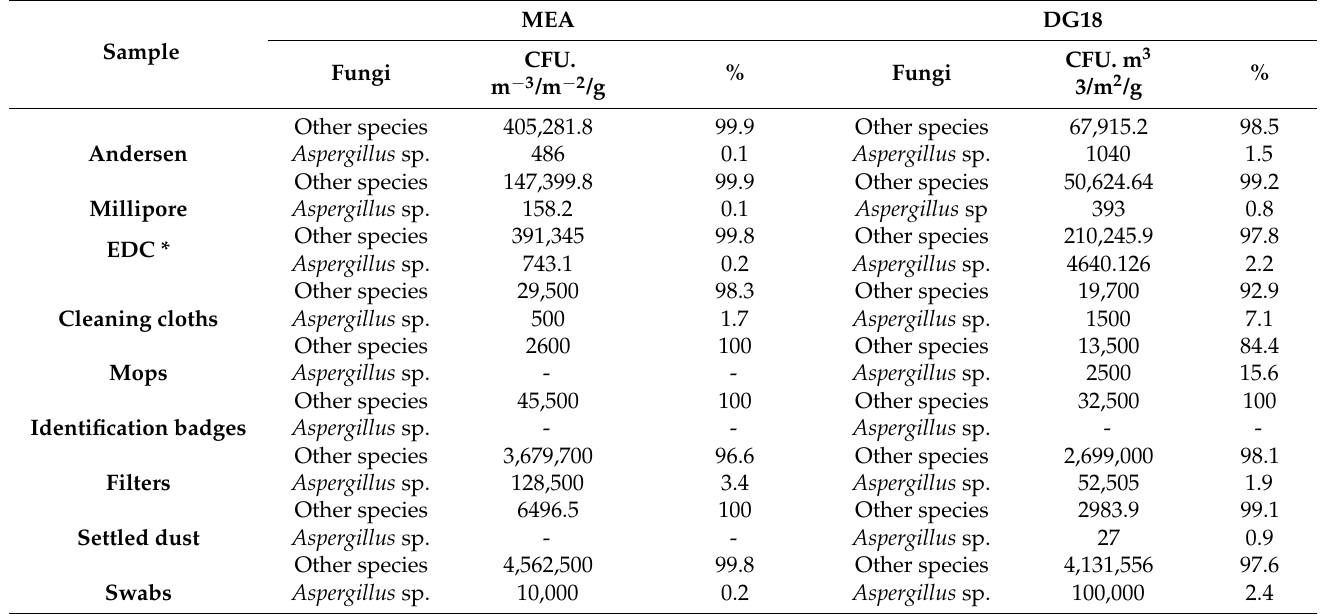
Table 3. Aspergillus sp. distribution in all matrices in MEA and DG18 from all FFHs.